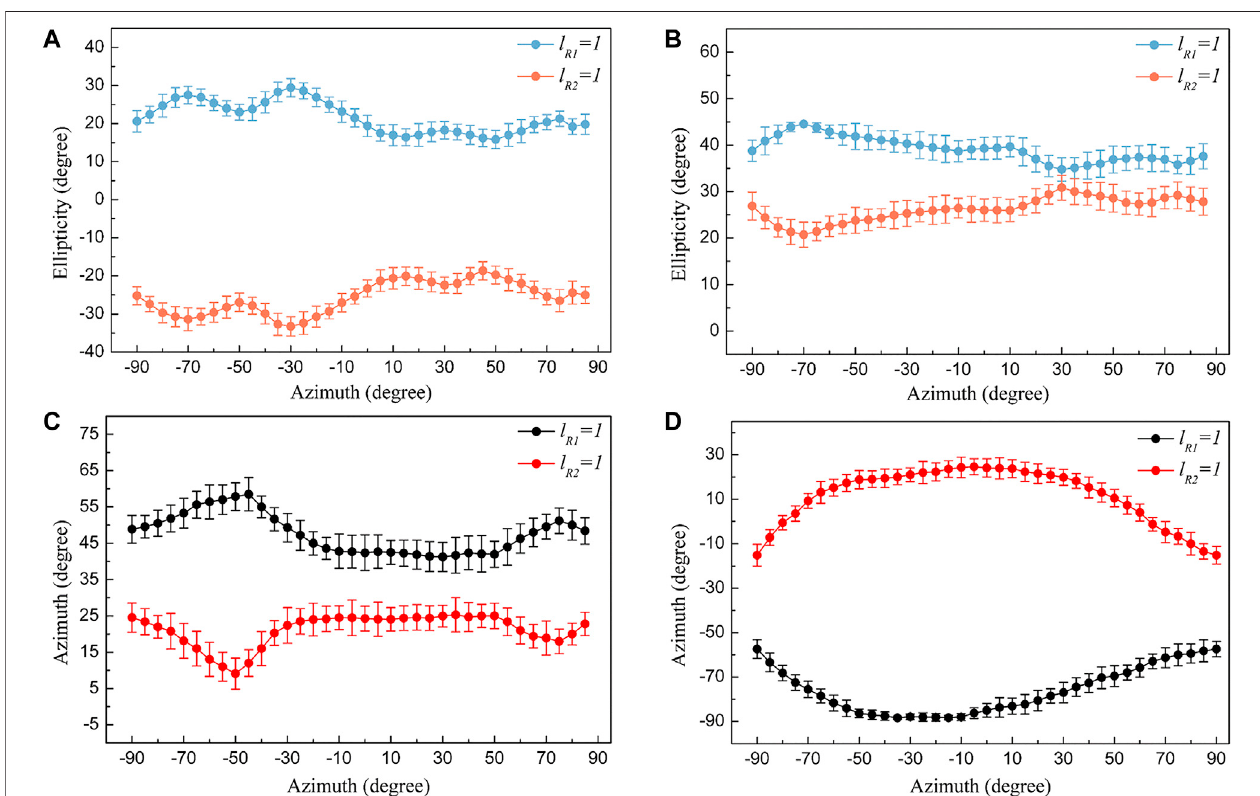
FIGURE 4 | Polarization manipulation through orbital polarization holography when TC = 1. Symmetrical ellipticity control of the − 1 st (A) and +1 st (B) diffraction orders from OPHGs ( l R1 = 1 and l R2 = 1) with the polarization direction of the probe light being modulated from − 90 ° to 90 ° at an interval of 5 ° . Similar to the ellipticity, the azimuth of the − 1 st (C) and +1 st order (D) polarized diffraction light from the two OPHGs is controlled to change